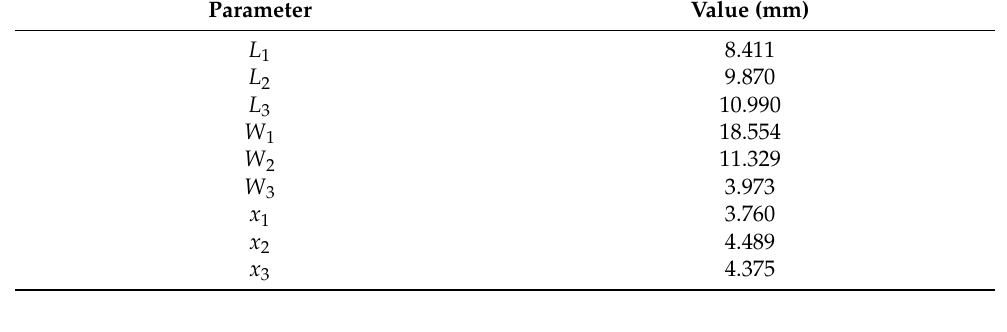
Figure 8. Simulated reflection coefficient for MPA1, MPA2, and MPA3.